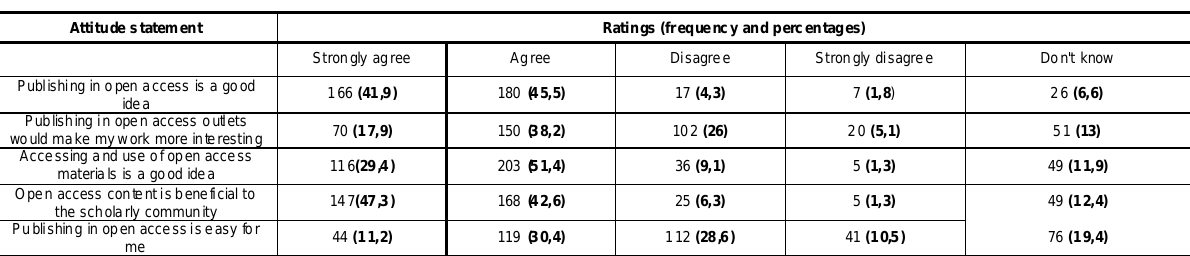
Researchers' attitudes towards open access